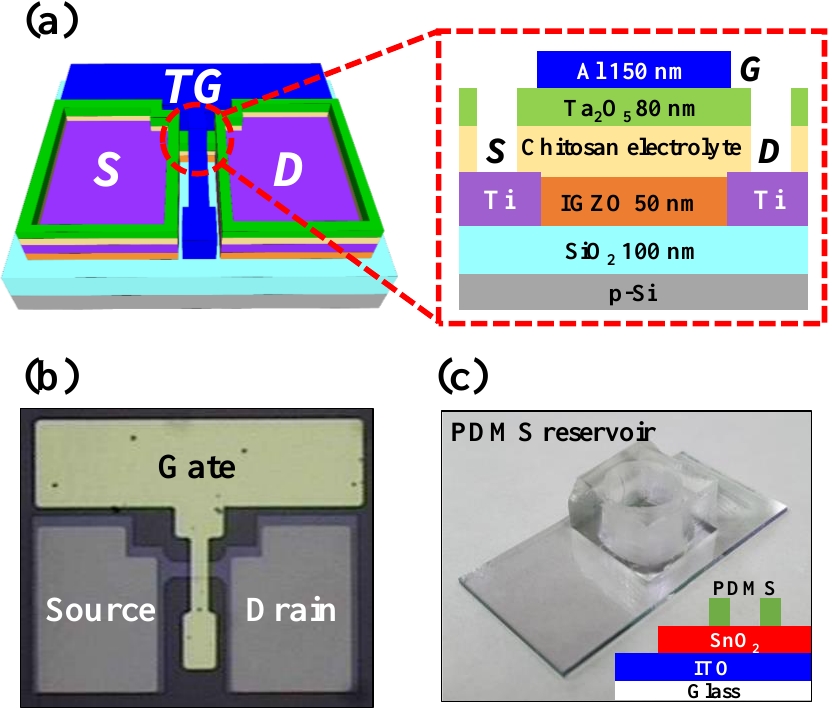
Figure 1. ( a ) Schematic in three-dimensions and in cross-section. ( b ) Optical microscopic image of the fabricated chitosan/Ta 2 O 5 hybrid dielectric electric-double-layer transistor (EDLT). ( c ) SnO 2 extended gate (EG) on ITO/glass substrate.